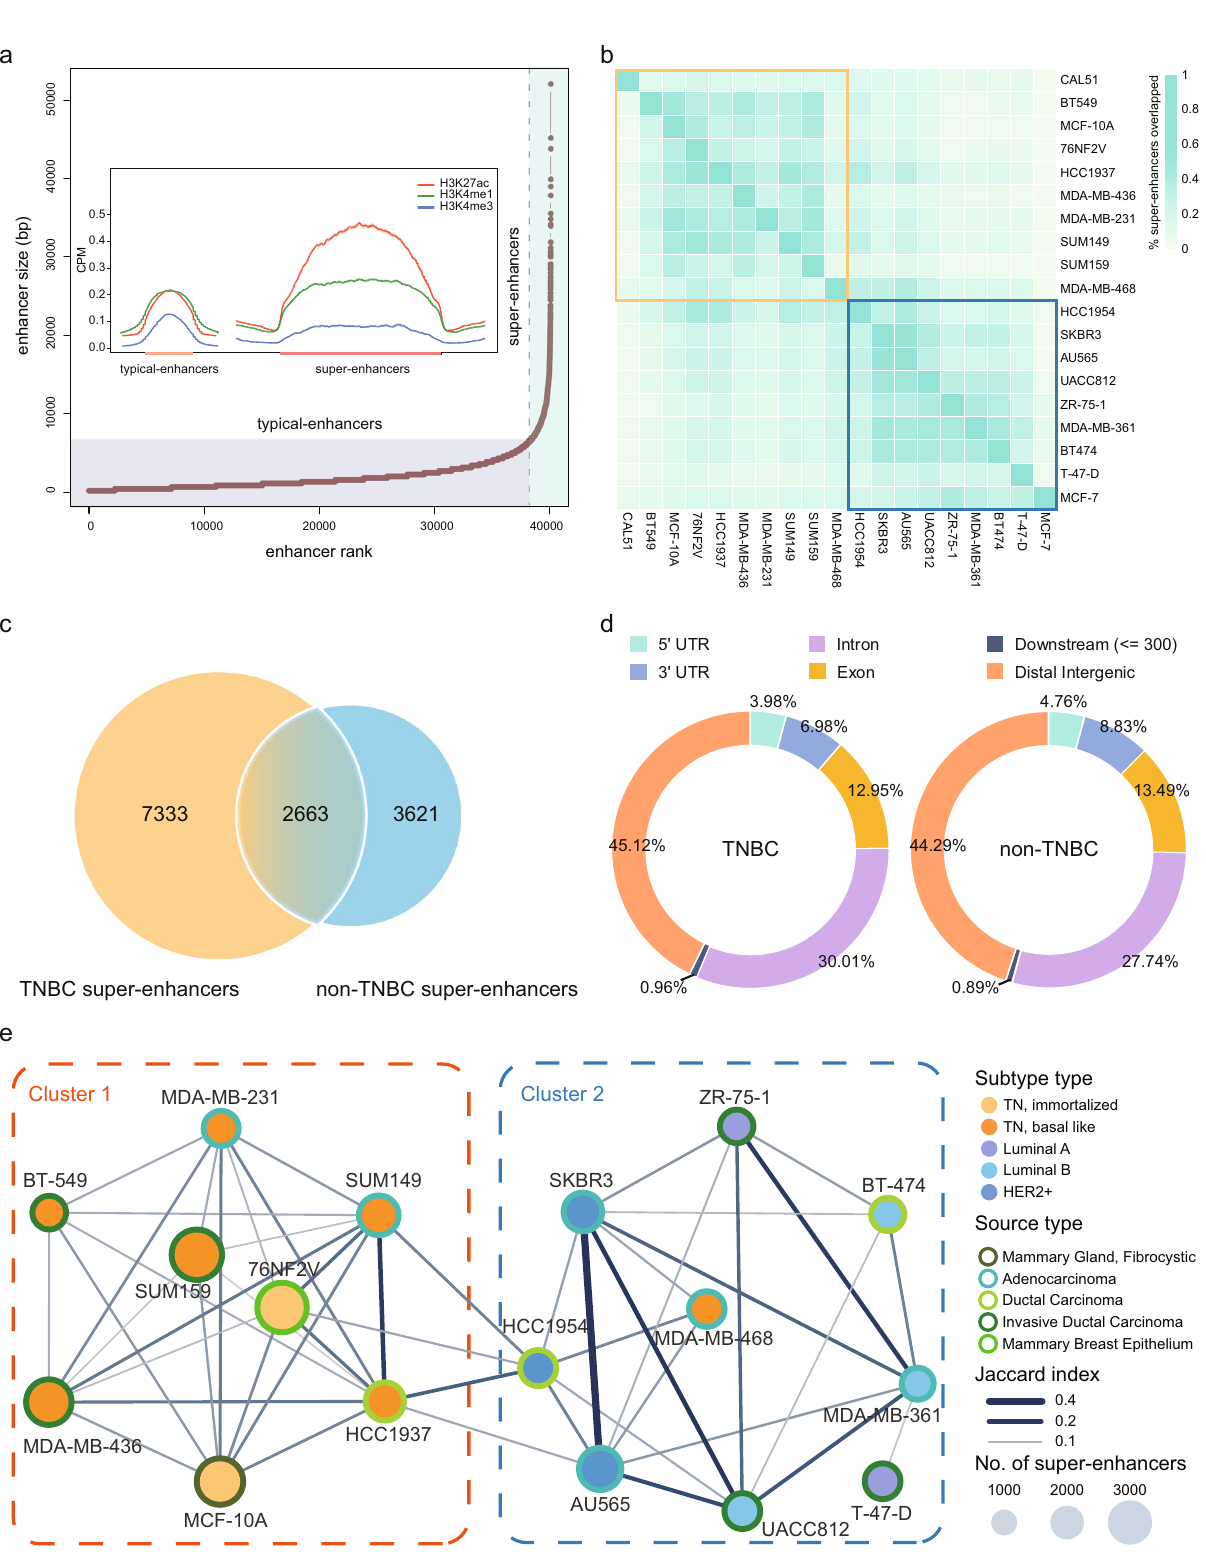
did not meet the thresholding conditions of our network (Supplementary Data 1, Jaccard similarity coef fi cient > 0.1